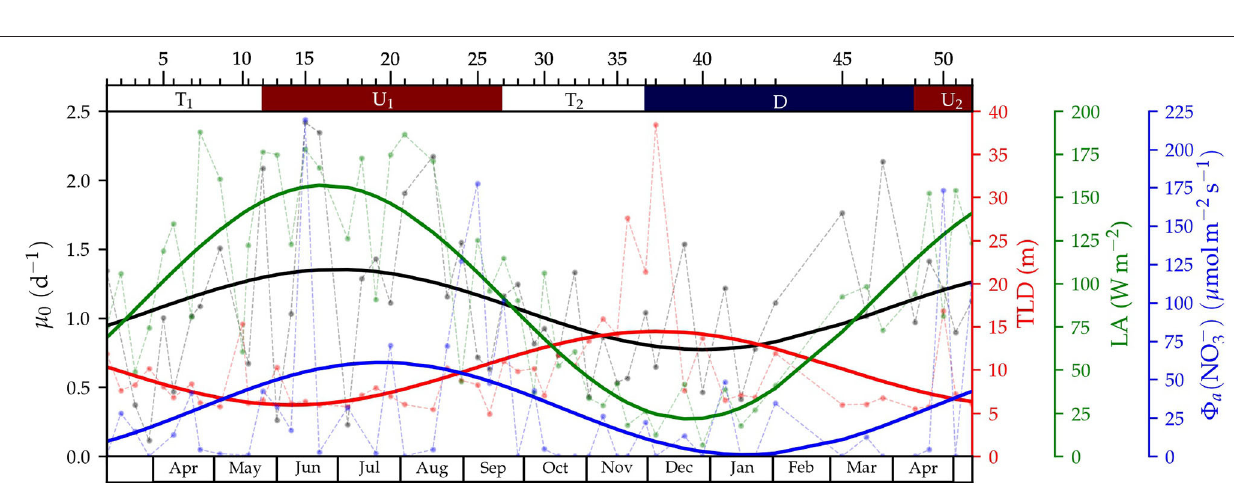
lower values were computed for the transitional T 2 (0.72